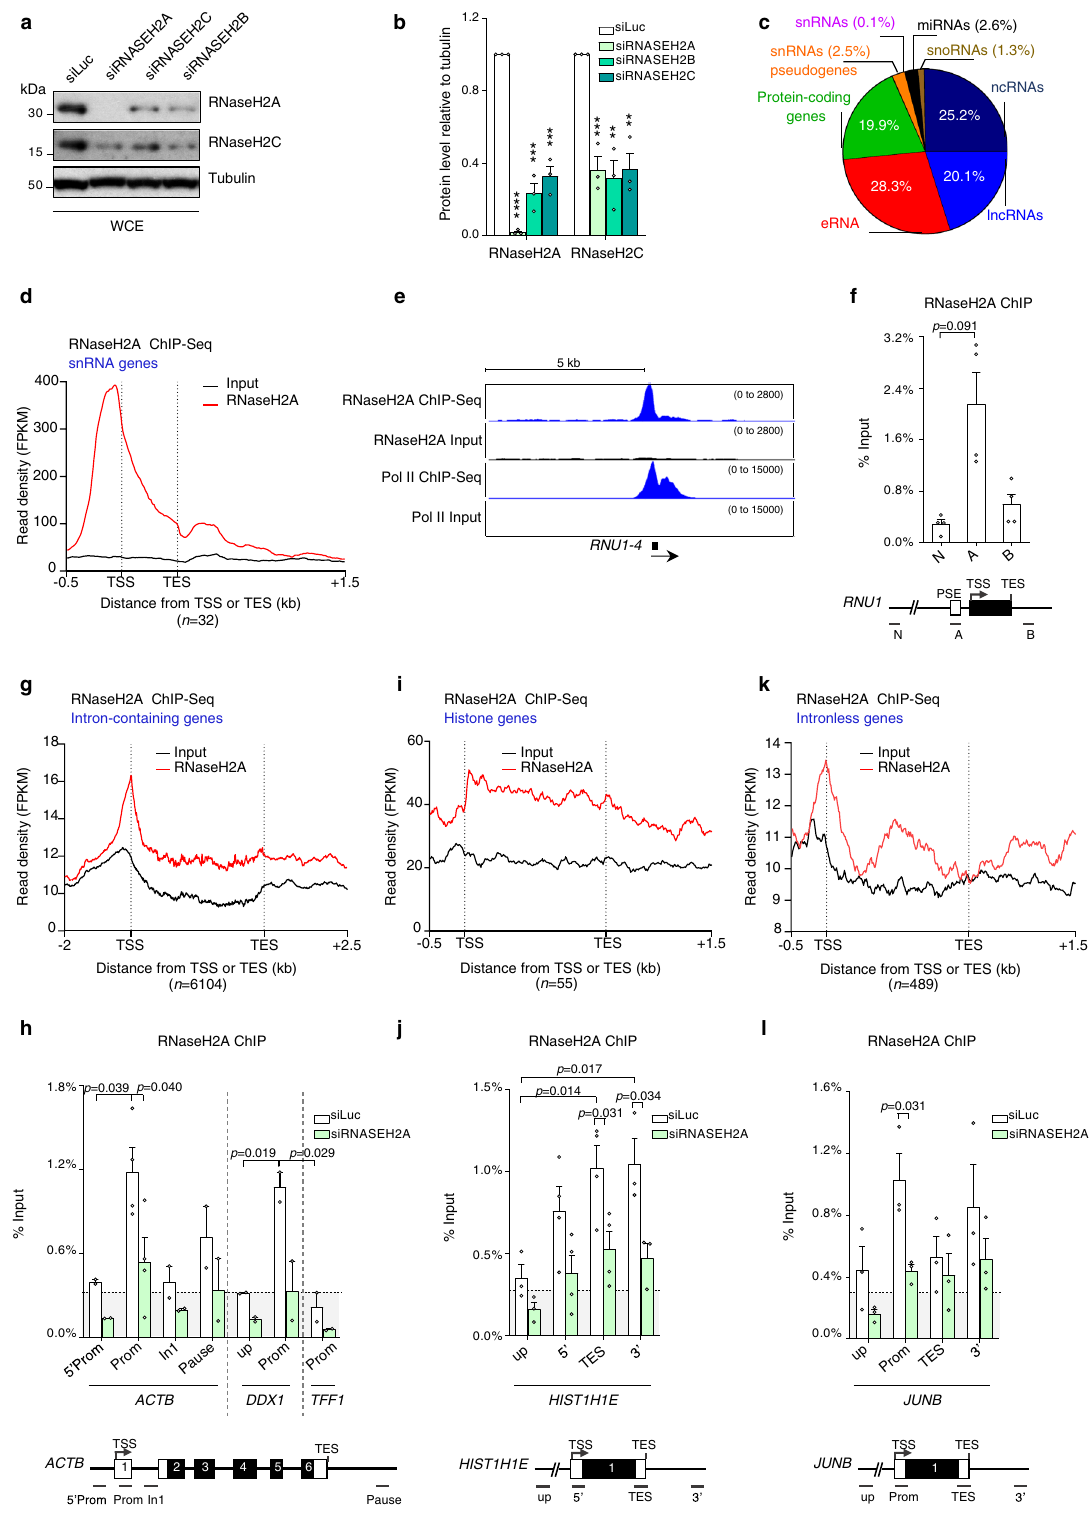
RNase H2A association with ACTB and HIST1H1E , suggesting that RNase H2 binding at these genes requires active transcrip- tion (Fig. 2b – d, g). Next we examined if replication is required for RNase H2 association with transcribed genes. ChIP-qPCR showed that RNase H2A binds RNU1 and ACTB genes in non- replicating fi broblasts, induced into a quiescent state by serum- starvation (Fig. 2e – g). This is in line with previous studies in